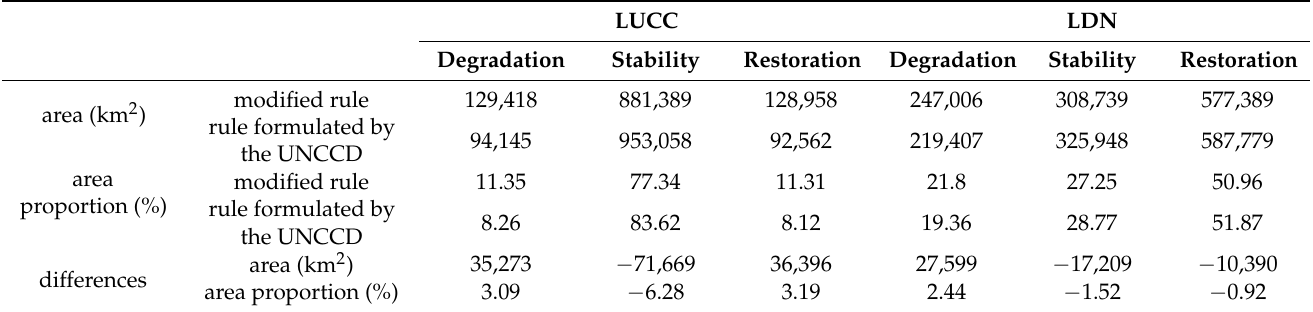
Table 4. Comparison of LUCC and LDN evaluation results before and after